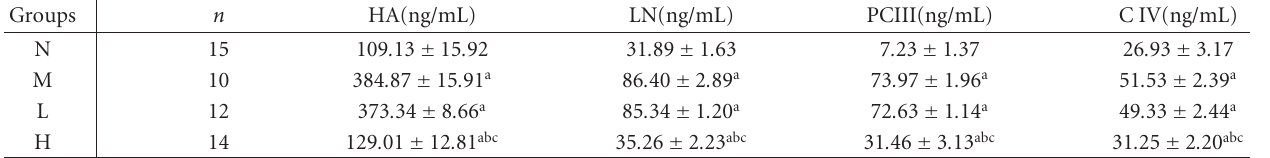
Table 2: Analysis of serum liver fibrosis indexes. Data are presented as mean ± standard error of the mean. N represented the normal control group; M represented the model group; L represented the group treated with low dose of thalidomide; H represented the group treated with high dose of thalidomide.